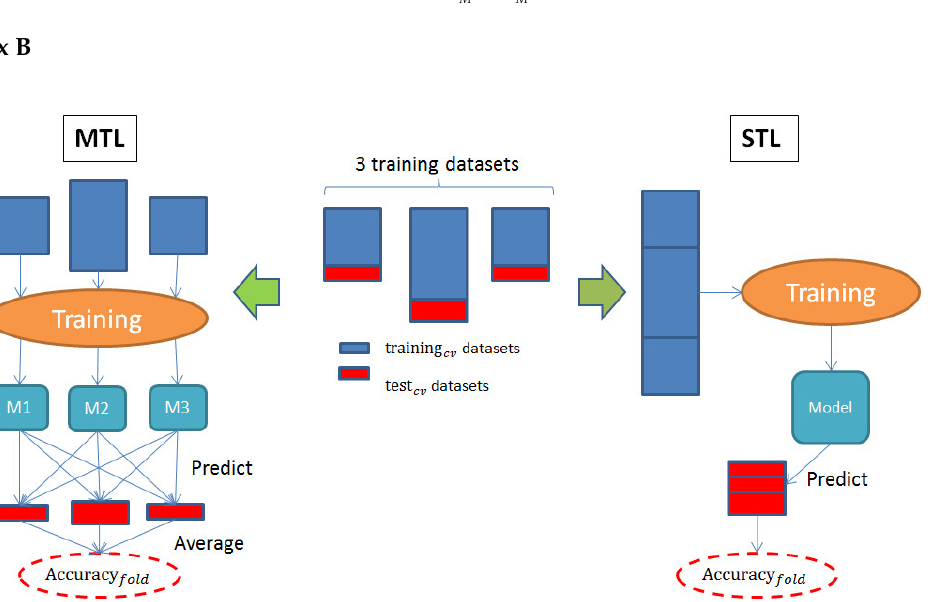
Figure A1. Procedure of five-fold-stratified-cross-validation for Single Task Learning (STL) and Multitask Learning (MTL) (showing one-fold as an example). Using n d = 3 as an example, the specific procedure of the cross-validation procedure is shown. First, the subjects were randomly allocated to five folds, stratified for diagnosis per dataset. Subsequently, different strategies were specified for MTL and STL. For MTL, the training datasets were trained in parallel, and the three models (M1, M2, and M3) were tested on each test dataset by averaging the prediction score. The average across all accuracies was used as the final accuracy for the current fold. In contrast, for STL, the training datasets were combined to train a single algorithm that was then predicted on the combined test